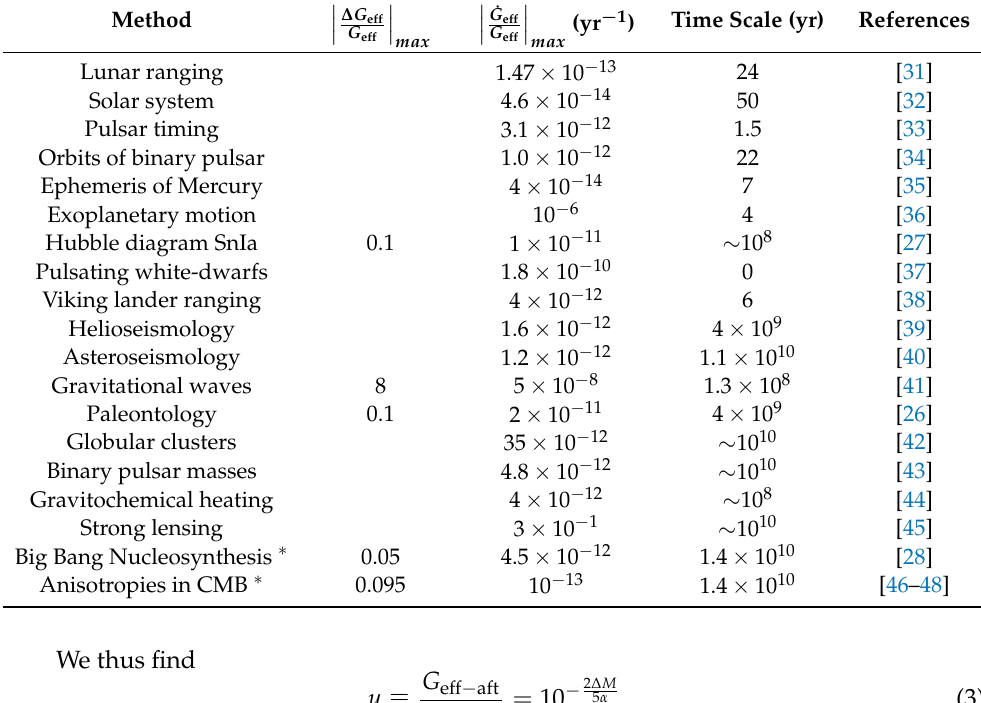
Table 1. Solar system, astrophysical and cosmological constraints on the evolution of the gravitational constant. Methods with star ( ∗ ) constrain G ∗ (connected with the Planck mass) while the rest constrain G eff . The latest and strongest constraints are shown for each method (updated from Ref.